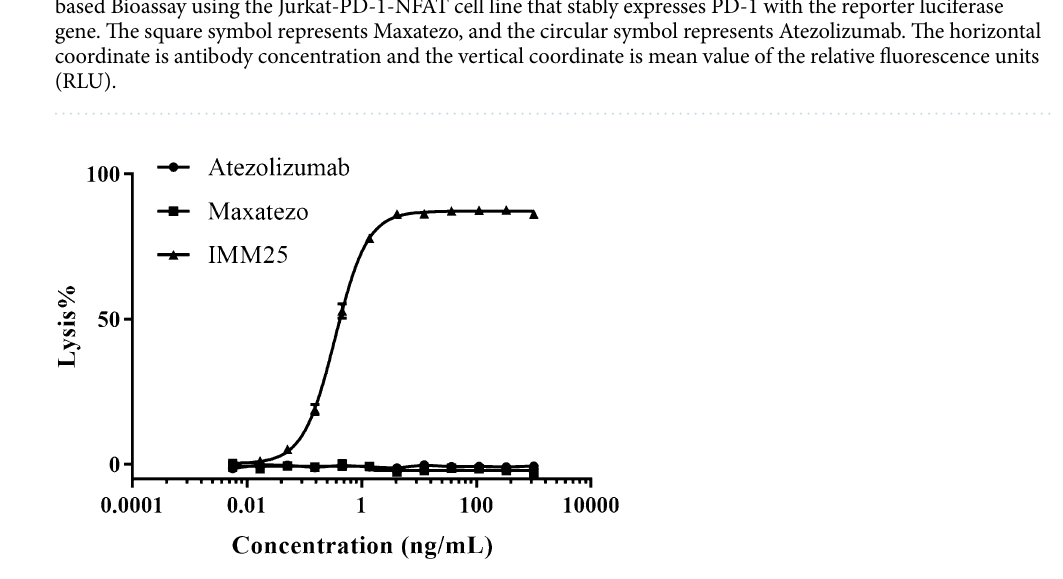
Figure 2. Insertion of GGGS removes ADCC activity completely. The ADCC activities of the different PD-L1 antibodies were measured by an in vitro cell killing assay using PD-L1-overexpressed Raji cells together with CD16a (158 V)-overexpressed NK92MI cells in the presence or absence of PD-L1 antibodies. The line with triangles represents the IMM25 (ADCC- enhanced anti-PD-L1 antibody), the line with squares represents the Maxatezo, (anti-PD-L1 antibody with GGGS insertion), the line with solid circles represents the Atezolizumab (anti-PD-L1 antibody with N297A). The horizontal coordinate is antibody concentration and the vertical coordinate is the percentage of ADCC induced cell